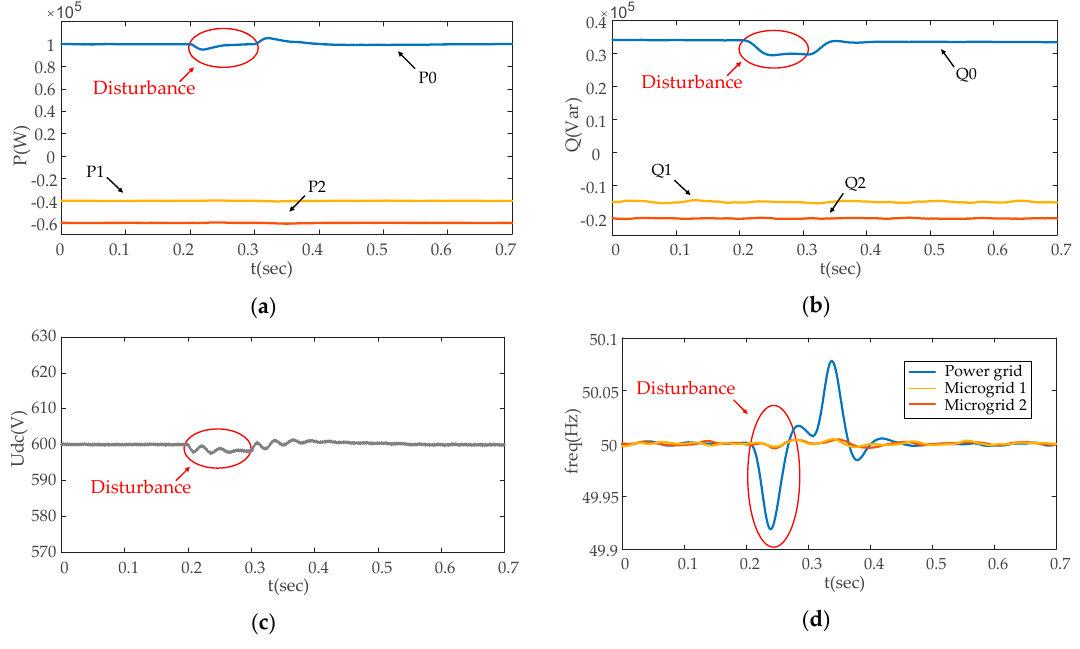
Figure 15. Simulation results of scenario 4: ( a ) active power curves; ( b ) reactive power curves; ( c ) DC-link voltage curves; and ( d ) frequency curves.